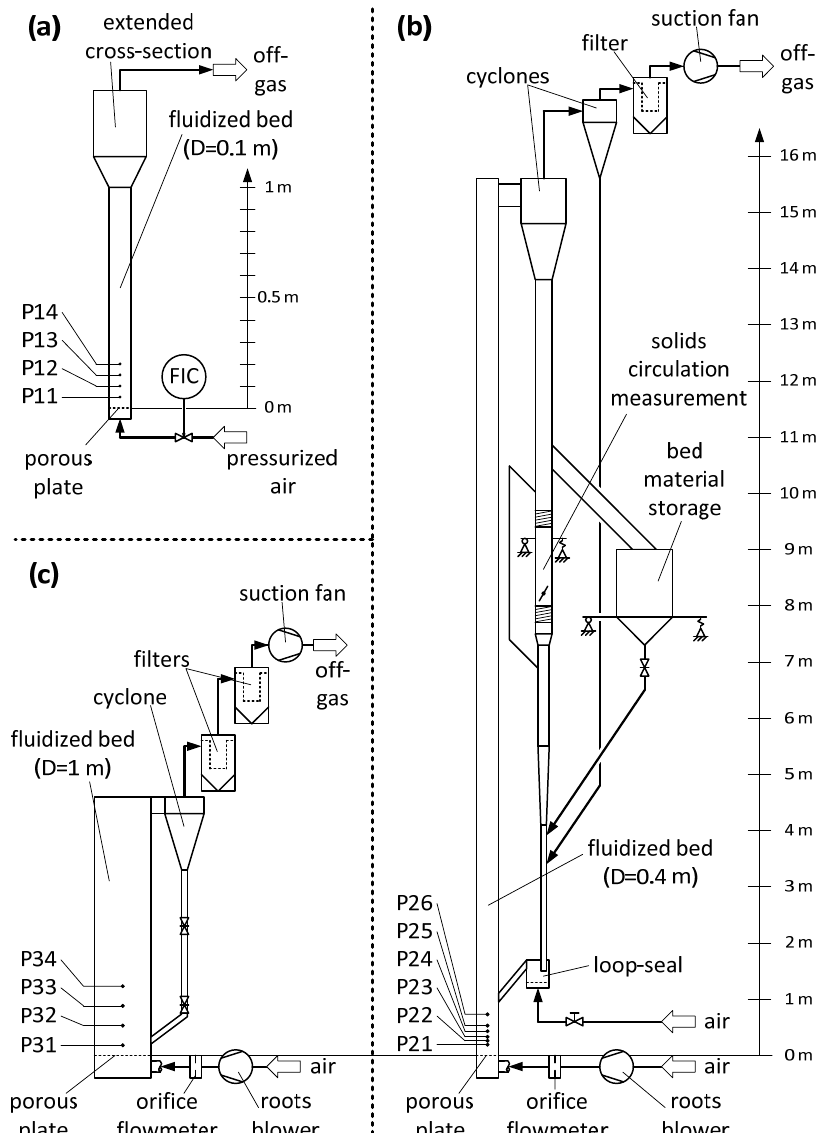
Figure 1. Flow sheets of the fluidized bed facilities having diameters of ( a ) D = 0.1 m, ( b ) D = 0.4 m and ( c ) D = 1 m including the different capacitance probe measurement ports used.